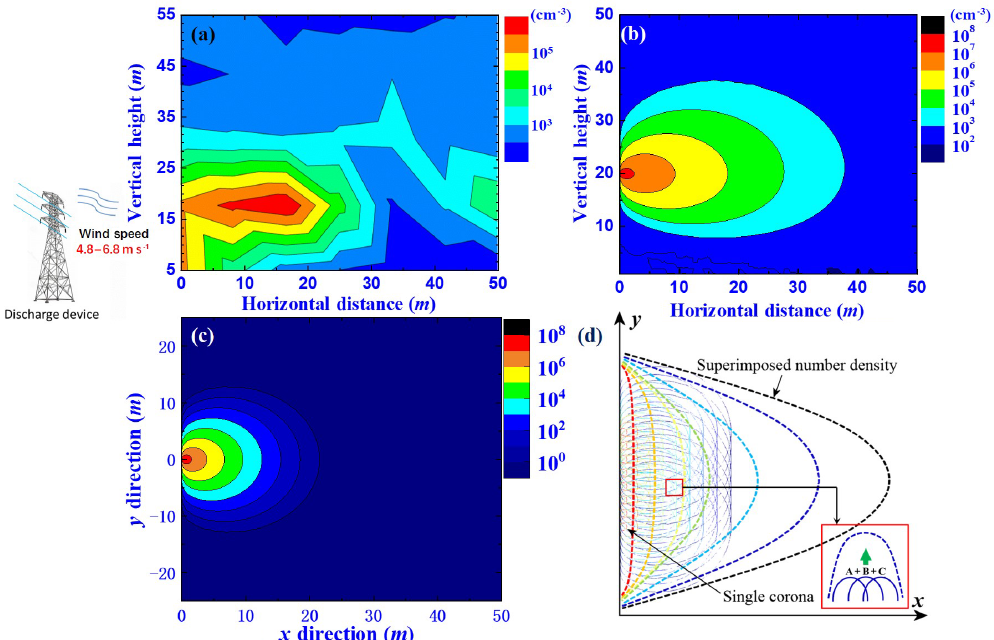
Figure 6. The coverage area of the large corona discharge system is a combination of the coverage areas of a very large number of corona discharge points. (a) The ion density distribution in the vertical direction and downwind direction (experimental measurement, applied voltage − 90kV). (b) The ion density distribution in the vertical direction and downwind direction (simulation, z axis, vertical direction, x axis, horizontal direction). (c) The ion density distribution of a single corona discharge point ( − 90kV) in the horizontal direction ( x – y axis). (d) The combination of ions generated by multiple corona discharge points resulted in a high negative ion density in the open air. The dashed colored lines from red to black suggest the ion density decreases as the distance from the wire electrode increases. The inset indicates that the combination of ions generated by three corona discharge sources increases the coverage of ions